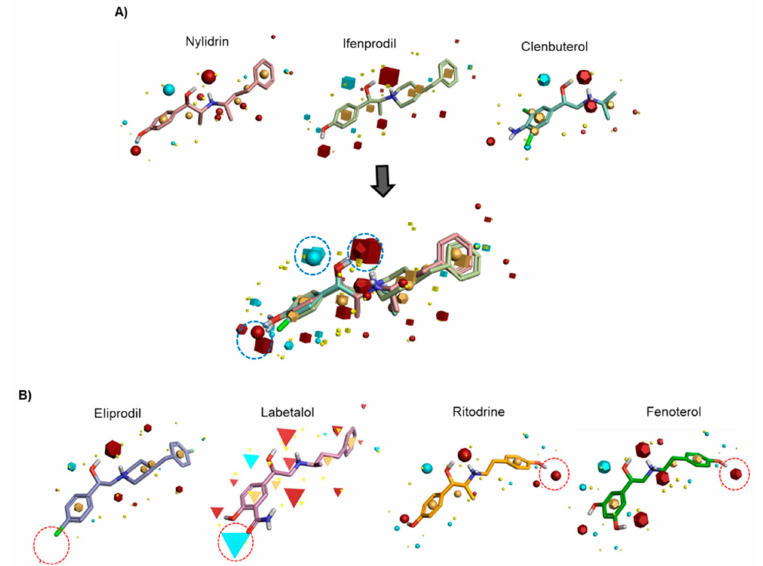
Figure 1. Identification of common pharmacophore active regions on the basis of field points from the ligand-based pharmacophore model. ( A ) Field-based template model of three active molecules, nylidrin, ifenprodil, and clenbuterol, and their merged image. Highly conserved electrostatic domains are highlighted in dotted blue circles. ( B ) Representation of four template compounds with little or no activity. Unfavorable electrostatic domains, distinct from the active compounds, are marked in dotted red circles. Field points are visualized as follows: blue, negative electrostatic potential; red, positive electrostatic potential; orange, hydrophobic; and yellow, van der